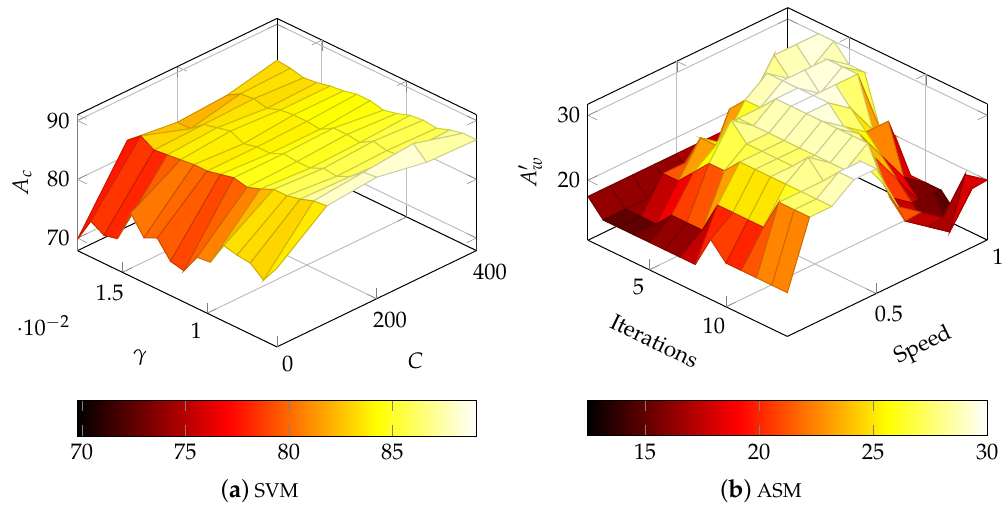
Figure 10. Optimisation of ( a ) SVM of the character group ( (cid:200) (cid:188) (cid:168) (cid:128) (cid:80) (cid:88) (cid:104) (cid:64) ) in isolated form: RBF kernel is use, so C and γ have to be optimized. ( b ) ASM Classifier (during word recognition); The speed and the number of iterations of the Gradient Descent algorithm are optimized, which are most important the Accuracy and performance of ASM based classification.